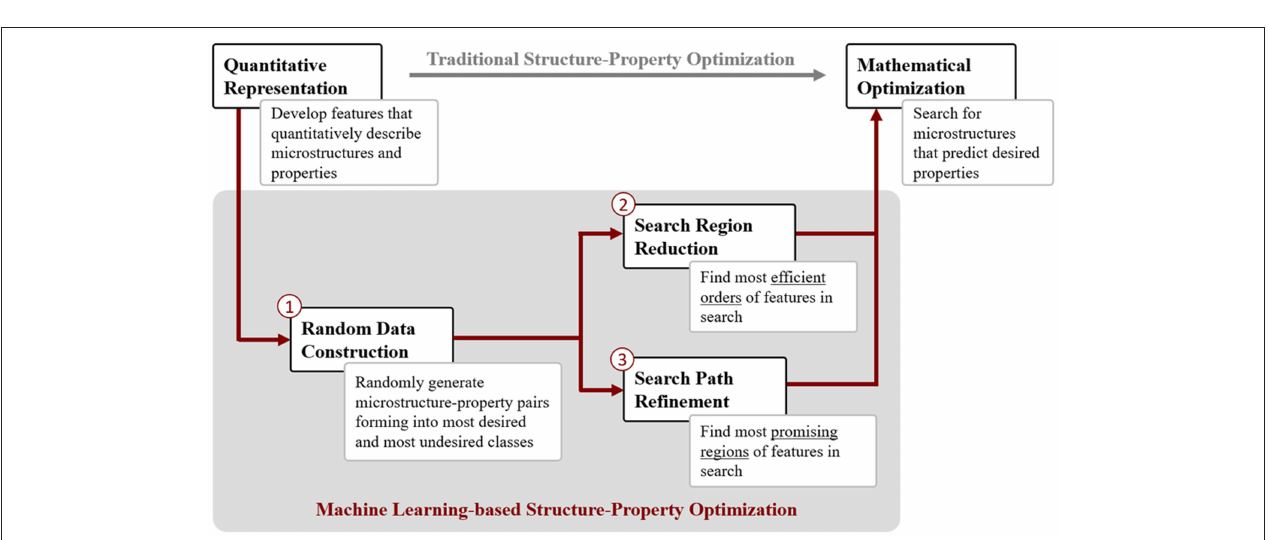
FIGURE 8 | Illustration of two schemes for structure-property optimization as presented by Liu et al. (2015a). The top illustrates the traditional structure-property optimization, usually based on a search-based optimization method. On the bottom, the machine learning-based structure-property optimization approach is presented. It includes three additional steps. First, data is generated and subsequently used to refine and reduce the search space dimensions, leading to optimal results, better performance and providing a better solution completeness compared to methods following the traditional optimization route. Figure “Framework of material structure optimization” reprinted from Liu et al. (2015a), used under the Creative Commons Attribution 4.0 license. http://creativecommons.org/licenses/by/4.0, Copyright (2015), font type and colors altered from